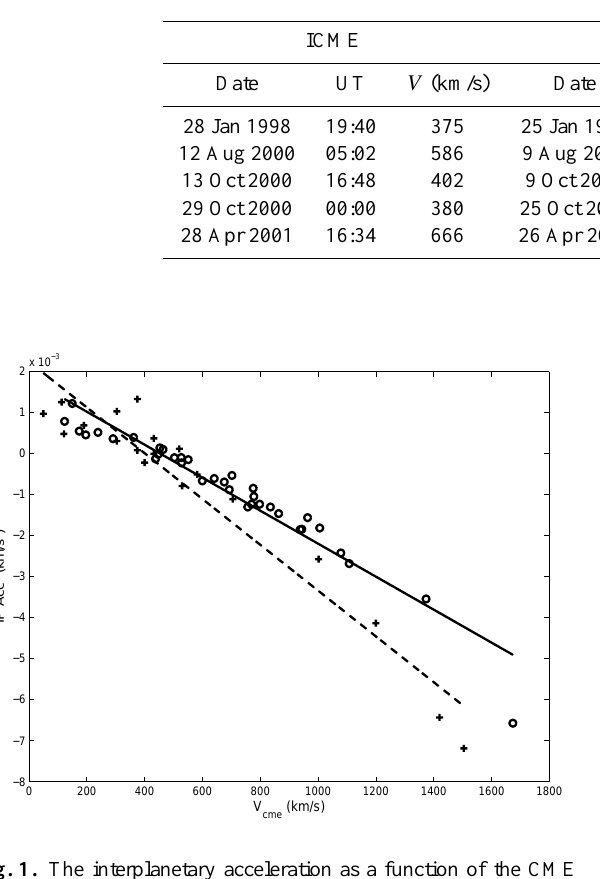
Table 1. The five additional CME-ICME pairs.